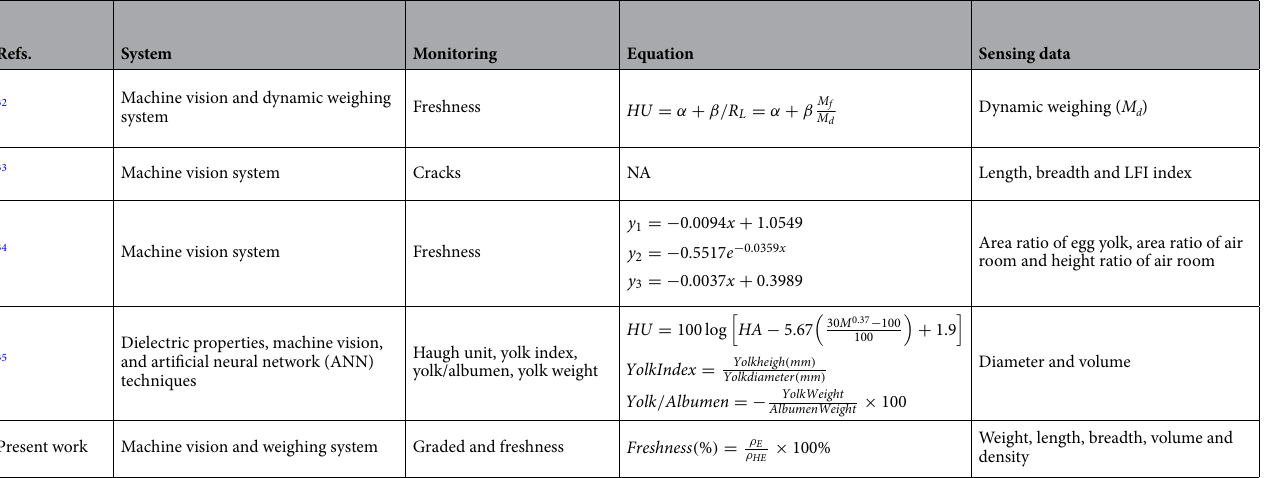
Table 4. The comparison of difference sensor for egg freshness detection based on machine vision. NA data not available, HU Haugh uni, α and β regression coefficients, M f weight of fresh egg estimated by long and minor axis sizes, M d the weight measured by dynamic weighing, y 1 the area ratio of egg yolk, y 2 the area ratio of air room, y 3 the height ratio of air room, HA the height of the thick Albumen, M the egg mass